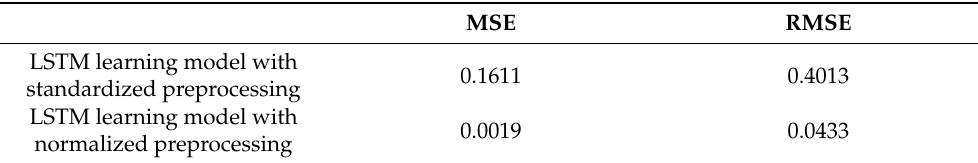
Table 4. Errors of the LSTM model with different preprocessing methods.